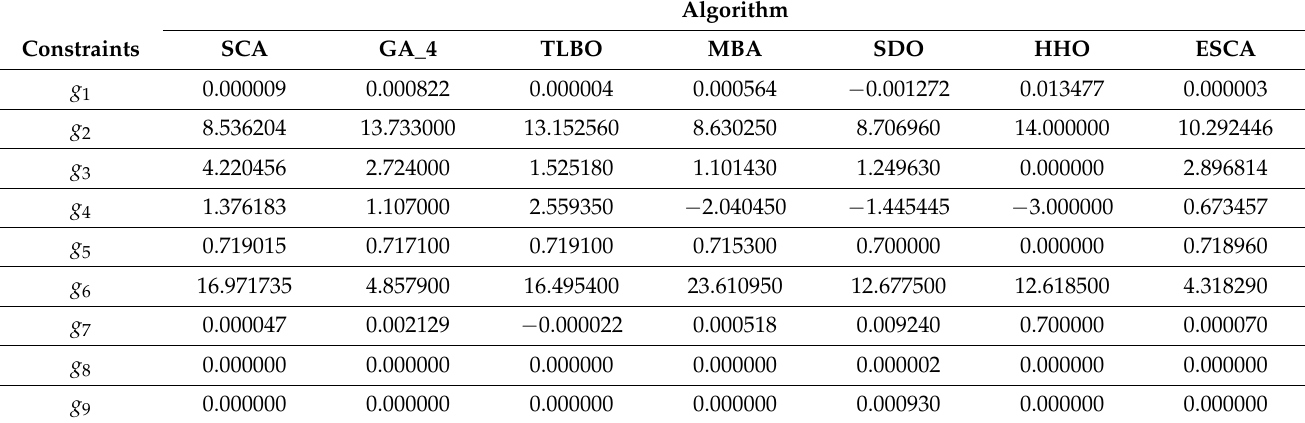
Table 29. Constraints of the best solutions obtained for the rolling element bearing design